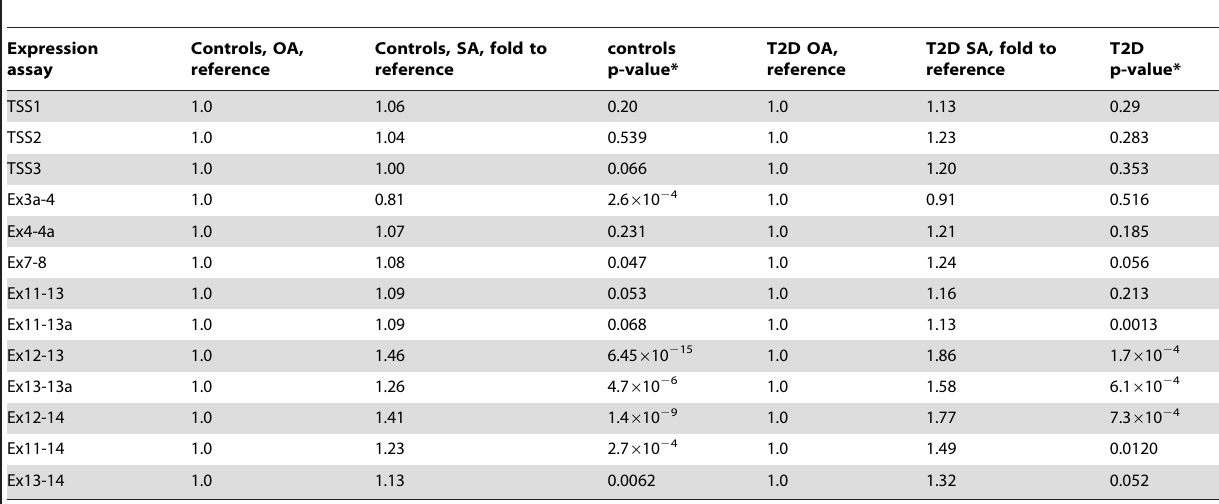
Table 4. Expression of TCF7L2 in omental and subcutaneous adipose tissue in controls (n=143) and T2D (n=16) groups.